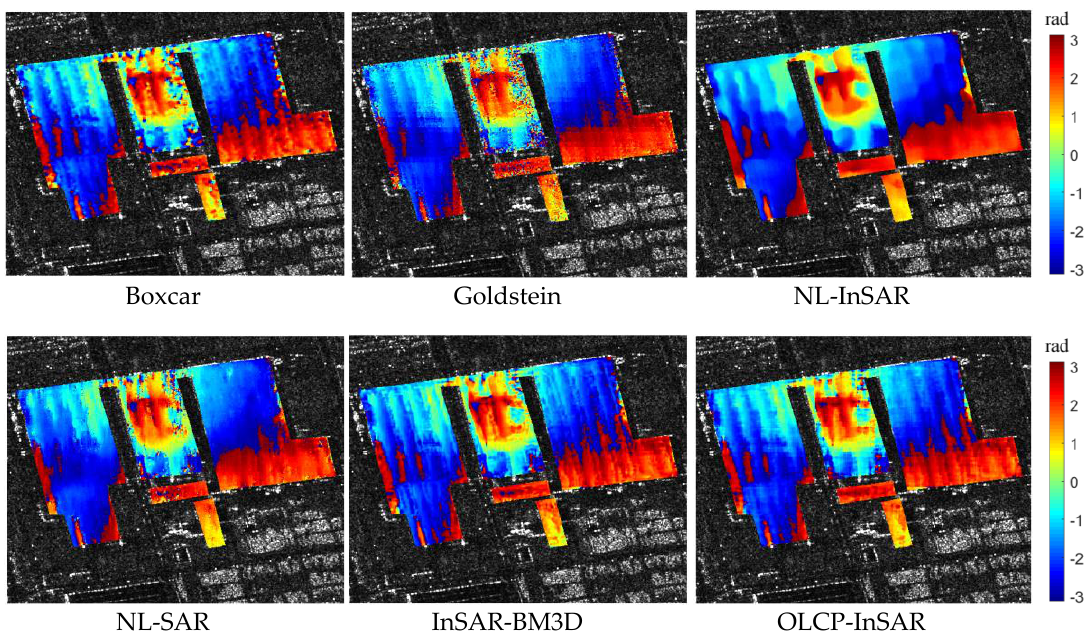
Figure 19. The filtered result of the second slice in the real InSAR tensor acquired by the filter operating on the matrix model.